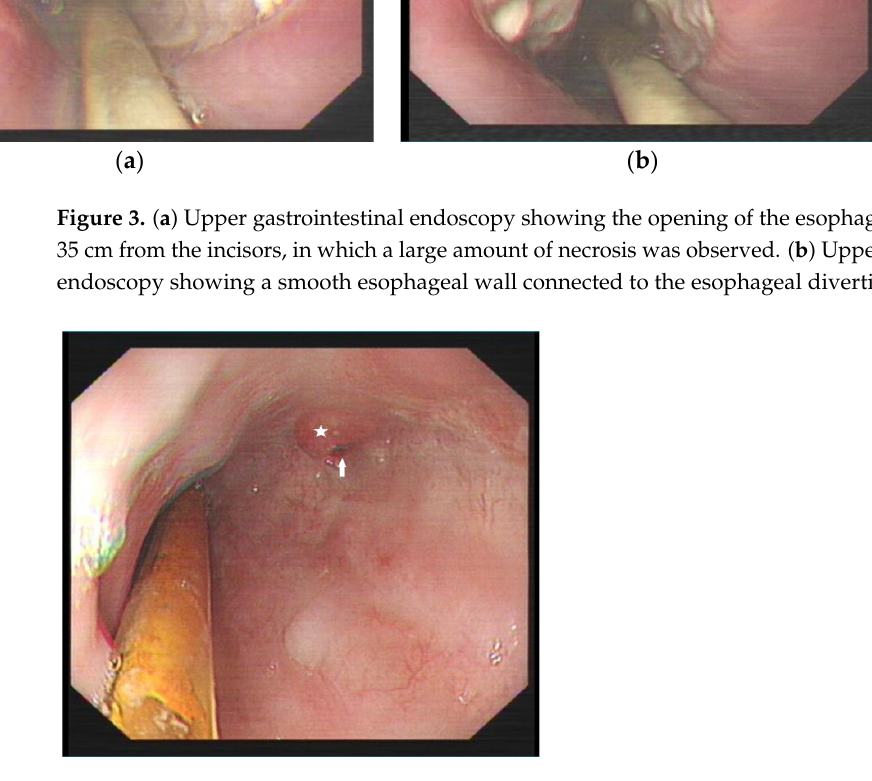
Figure 4. Re-examination of upper gastrointestinal endoscopy showing an esophageal diverticulum opening measuring 0.5 × 0.3 cm (arrow) with surrounding scar-like hyperplasia (star).